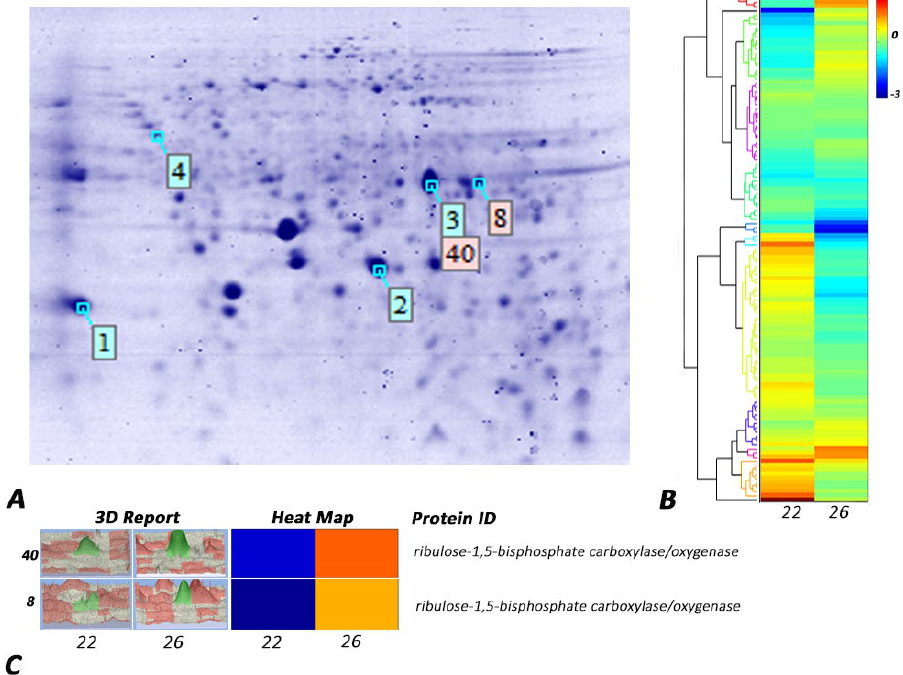
Figure 4. 2D Proteomics analysis. ( A ) Representative 2D PAGE gel of total leaf proteome of common bean line 26 in dried state stained with CBB. Numbers in blue boxes represent the landmarks used for matching between gels, and numbers in pink boxes represent the spots targeted for MS analyses. ( B ) Heat map visualization of the hierarchical clustering of matched spots represented by their log2 transformed averaged meanings of volume% in drought stress normalized to control levels of lines 22 and 26. Different clusters according to their linkage distance are shown with different colors. Color bars represent log2 fold changes of spots after drought stress normalized to their levels in control state ( C ) representation of identified proteins. Each spot number corresponds to the representative gel in ( A ) and is represented by the 3D report for each line in the dried state followed by Heat map visualization and protein ID. Color code for Heat map corresponds to the color bar in ( B ).